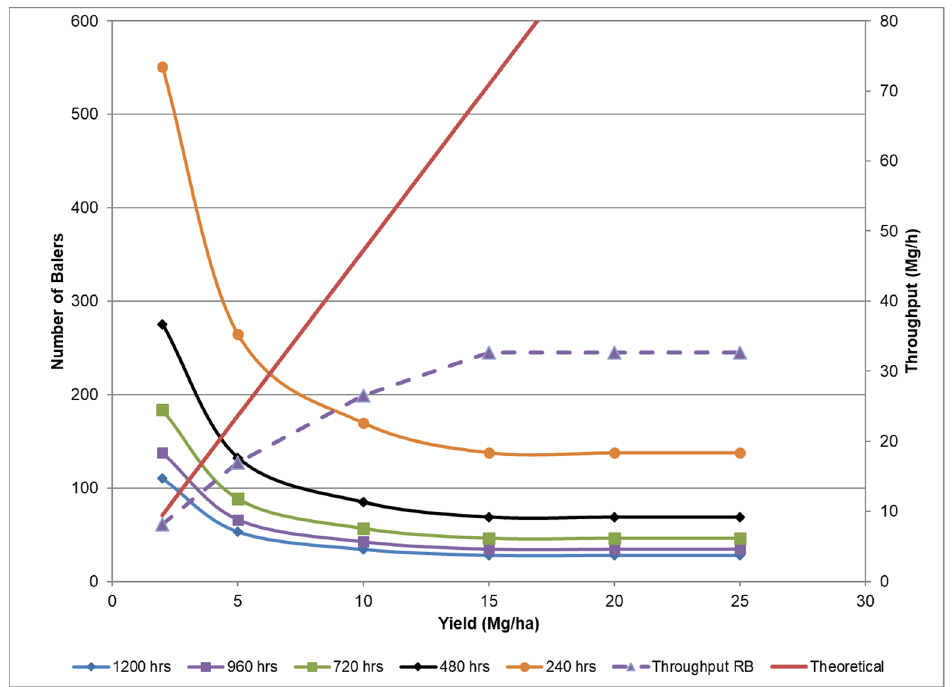
Figure 5. Number of round balers required to supply a 3000 Mg/day biorefinery. The solid red line is the theoretical throughput capacity of the baler and the dashed line is the baler-achieved throughput after adjustment for the bale wrap/eject time.